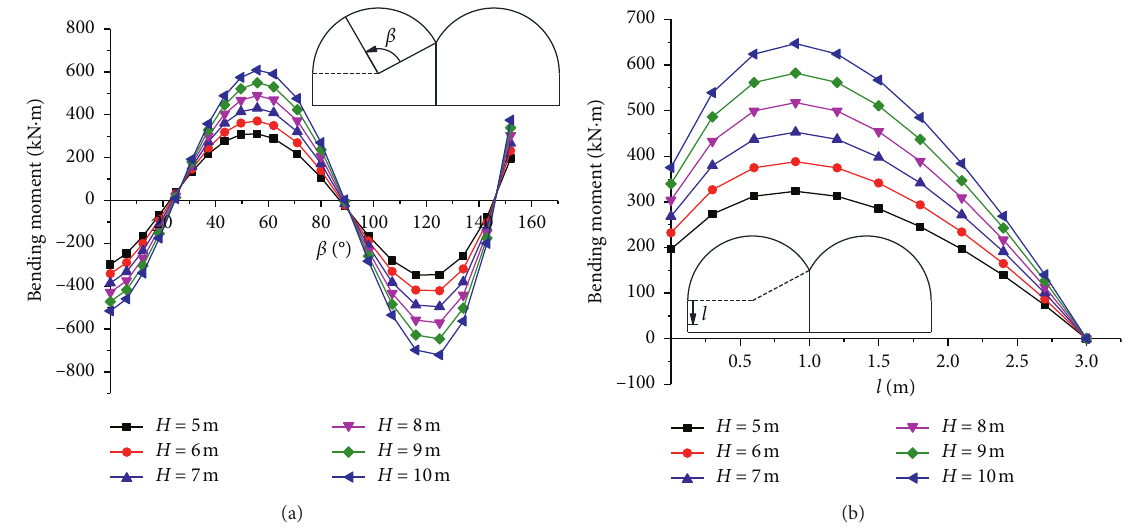
Figure 11: Variations of bending moment with ( H ): (a) along the arch ring; (b) along the side wall.